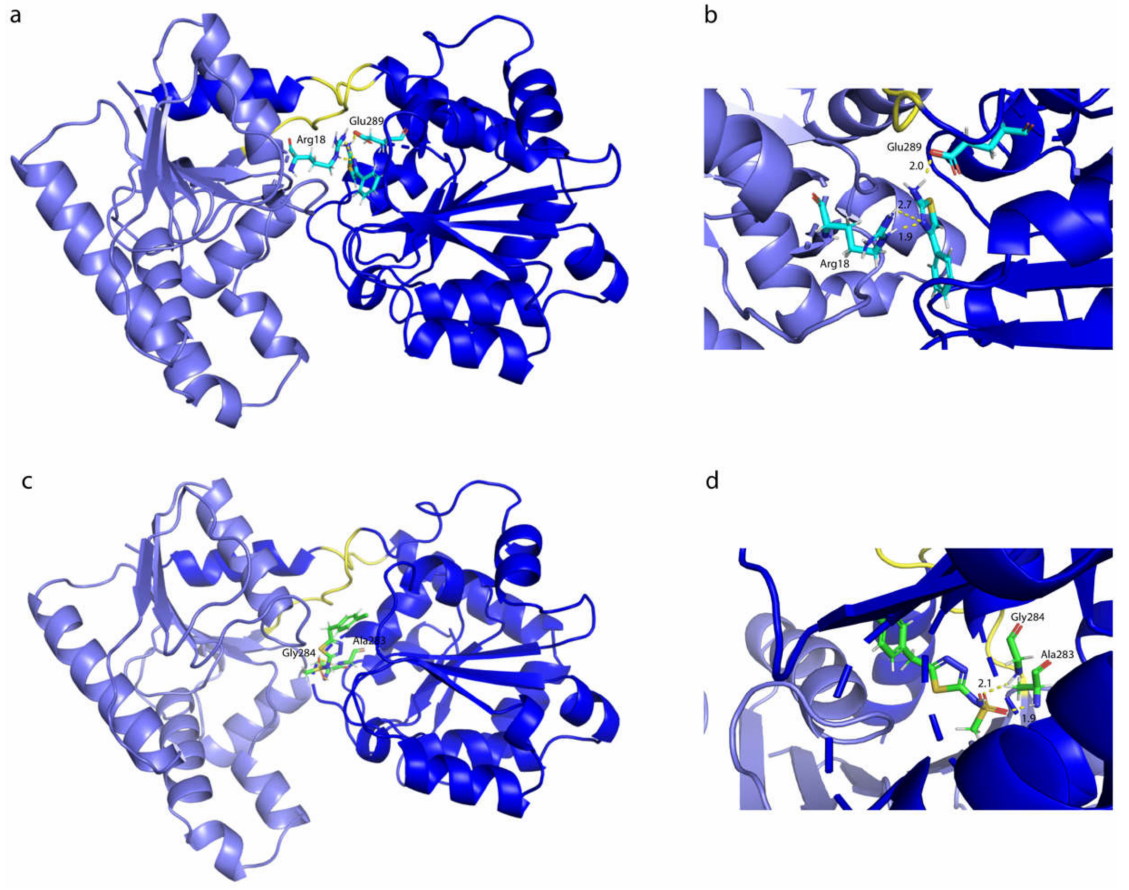
Figure 13. Molecular dynamics representation and interactions of ligands ( a , b ) A4 and ( c , d ) B33 with WaaG binding pocket. The structures are the most representative of the different clusters identified for each